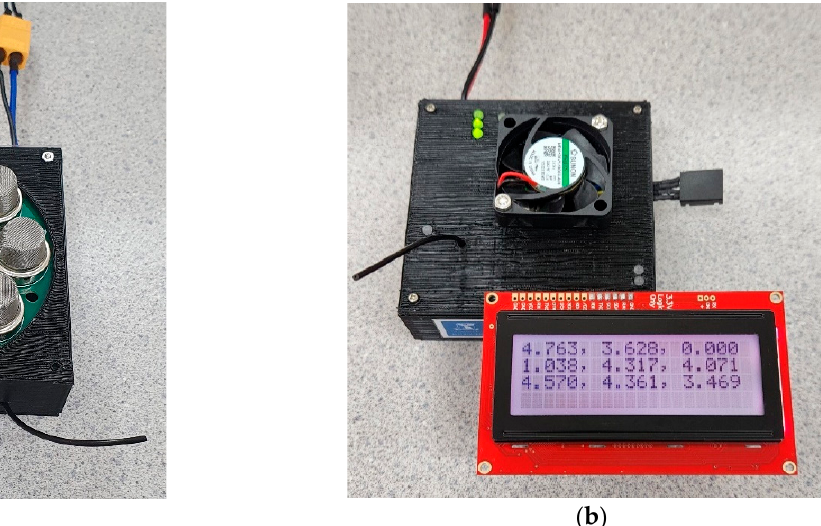
Figure 1. Low-cost electronic nose used in this study showing ( a ) the different sensors and ( b ) ex- tracting fan and liquid-crystal display (LCD) screen for data monitoring. The e-nose has connectivity for an external battery and wireless data transmission capabilities.